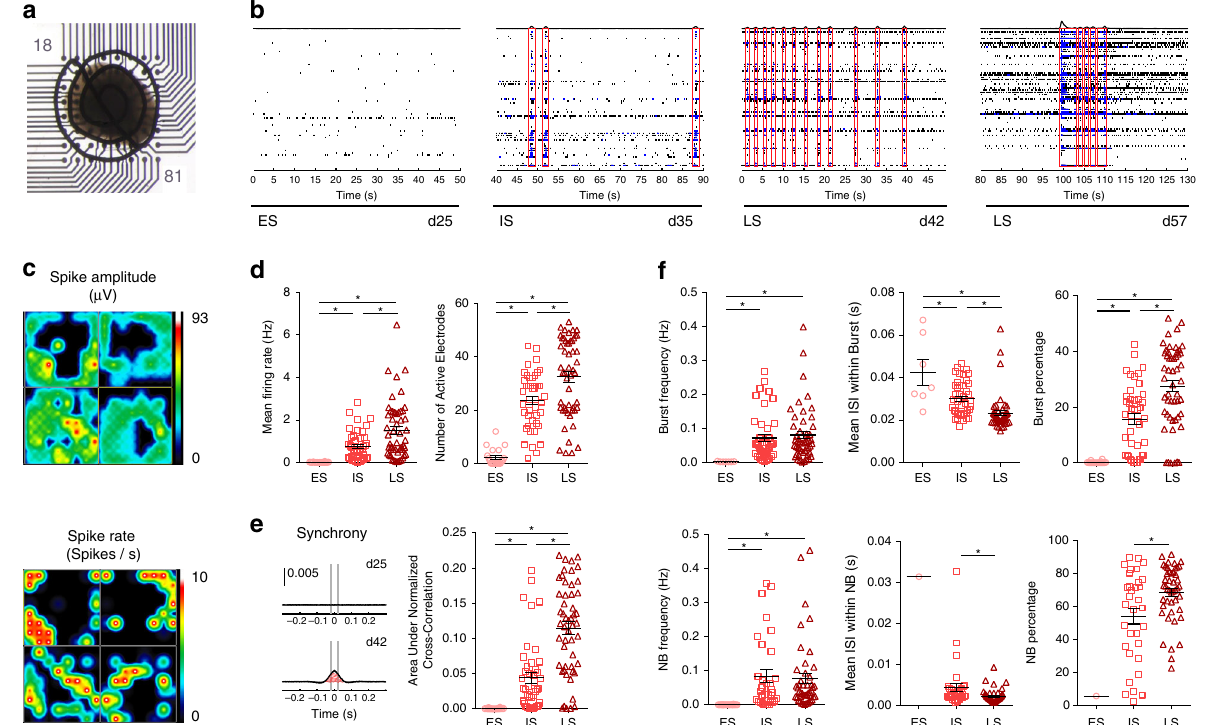
Fig. 5 BENOs develop complex network bursts in a course of 2 months. a Bright fi eld image of a 300 µ m BENO slice mounted on a 64-electrode MEA plate. b Representative traces of ES, IS, and LS BENO neuronal networks activity in a 50 s time frame. Note that NB complexity increased with time. c Activity heat maps showing spike amplitude ( µ V) and spike rate (spike/s). d General activity parameter such as mean fi ring rate and number of active electrodes increased with time. e Left, representative traces of synchronous activity measured at d25 and d42. Right, the area under the normalized cross- correlation plot (red stripes) was used as a measure of synchrony. f Frequency (in Hz), interspike interval (ISI) between burst events (in seconds), and percentage of spikes organized in bursts (in % or total spikes) of and frequency of NB (in Hz). Every dot represents the result of a 10 min measurement of a single BENO. BENO activity was measured daily and results were pooled in ES, IS and LS BENO groups according to the respectively de fi ned time window (ES: <d25; IS: d25 to d40; LS: d40 to d65 of BENO culture). d – f n = 4 organoids, 2 independent experiments. * p < 0.05, one-way ANOVA with Tukey ’ s multiple comparisons post hoc test. In case of Mean ISI within NB and NB percentage in ( f ) * p < 0.05, unpaired two-tailed Student ’ s t test. Data are presented as mean values ±